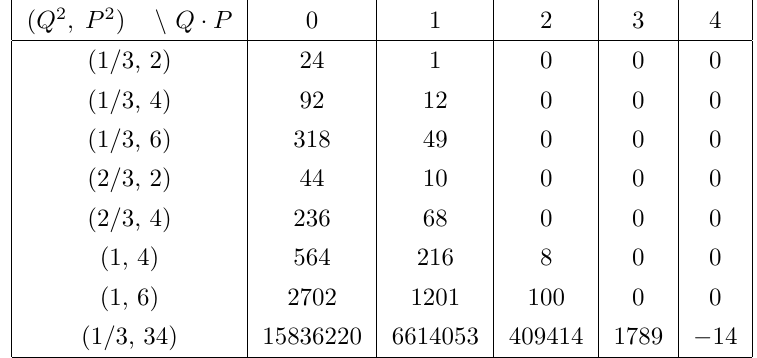
Table 9 . Index of horizon states 6 A orbifold of K 3 .